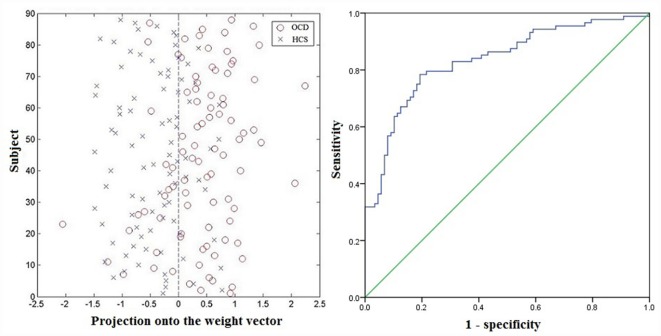
Classification plot (left) and receiver operating characteristic (ROC) curve (right) for differentiating patients with OCD from HCS based on ReHo maps, yielding an accuracy of 78.98% (sensitivity = 78.41%, specificity = 79.55%, P < 0.001). Abbreviations: HCS, healthy control subjects; OCD, obsessive-compulsive disorder; ReHo, regional homogeneity.